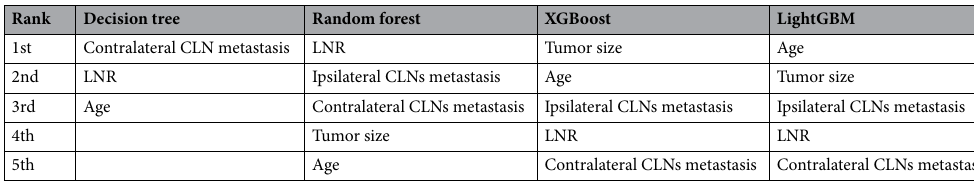
Table 4. Top five features of importance among machine learning models. LN lymph node, LNR lymph node